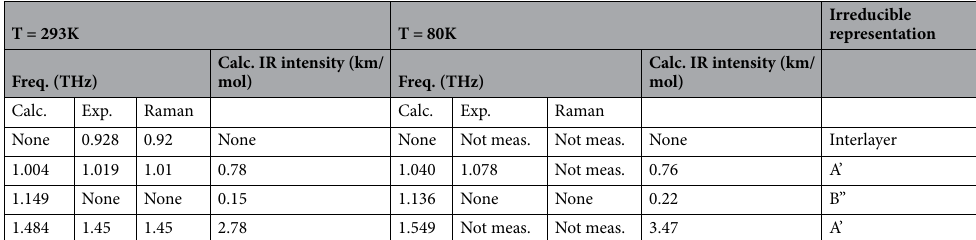
Table 3. Low-frequency vibrational modes of GUHP crystal unit cell at T = 80K and T =